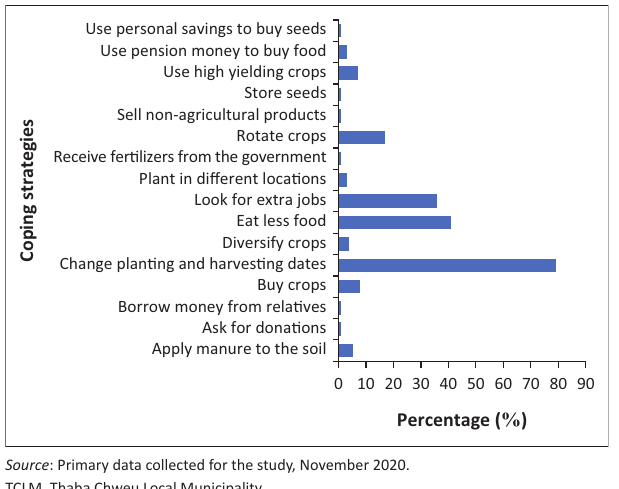
FIGURE 5: Coping strategies to climate variability and socio-economic challenges adopted by female